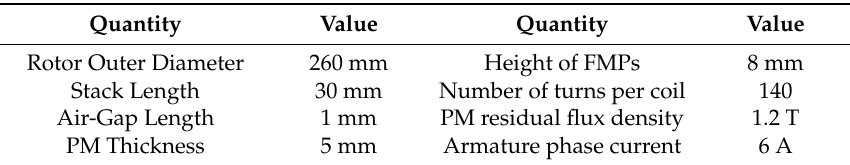
Figure 1. A structure of the surface-mounted permanent magnet vernier (SPMV) machine with non-overlapping windings. Table 1. Design